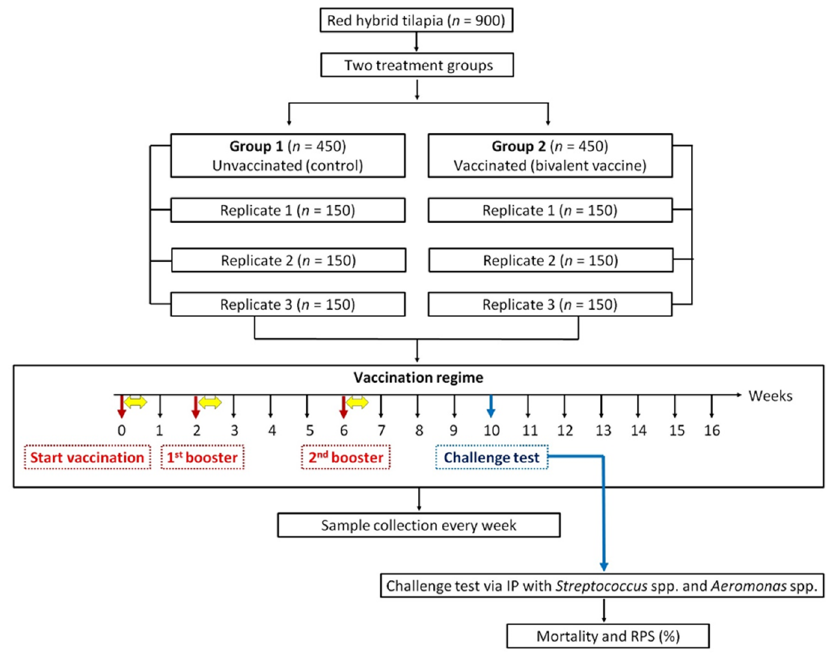
Figure 1. The experimental design flow chart used in this study. Fish in Group 1 were fed with the control pellets (PBS buffer + 10% palm oil) and acted as an unvaccinated (control) group. Fish in Group 2 were fed with the feed-based bivalent vaccine (whole-cell bacterial antigens + PBS buffer + 10% palm oil) and acted as a vaccinated group. Vaccination was delivered orally at 5% of the fish’s body weight for three consecutive days (yellow arrow) on weeks 0, 2, and 6. Samples (serum, gut lavage, and skin mucus) were collected every week for 16 weeks to assess the fish’s immunological response. Challenges via intraperitoneal injection (IP) with S. agalactiae , S. iniae , A. hydrophila , and A. veronii were conducted at week 10. The mortality and relative percentage survival (RPS) were observed for 14 days after the challenge test.